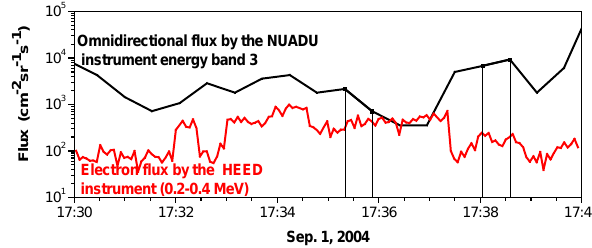
Fig. 5. The omnidirectional flux of electrons (black line) observed by the NUADU instrument in Energy Channel 3 (49.2–125keV), and the high energy (0.2–0.4MeV) omnidirectional electron flux (0.2 – 0.4 MeV) omnidirectional electron flux (red line) simultaneously (red line) simultaneously observed by the HEED instrument, on 1 September 2004. The vertical black lines indicate the periods of the frames under study (Fig.